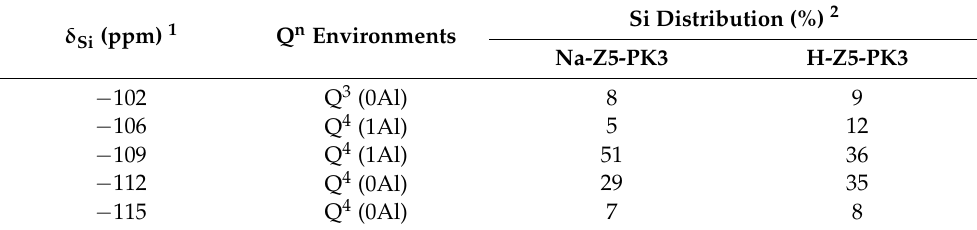
Figure 5. Solid–state ( a ) 27 Al and ( b ) 29 Si MAS NMR spectra of Na-Z5-PK3 ( top ) and H-Z5-PK3 ( bottom ). Table 2. Relative peak areas of the 29 Si MAS NMR spectra of the